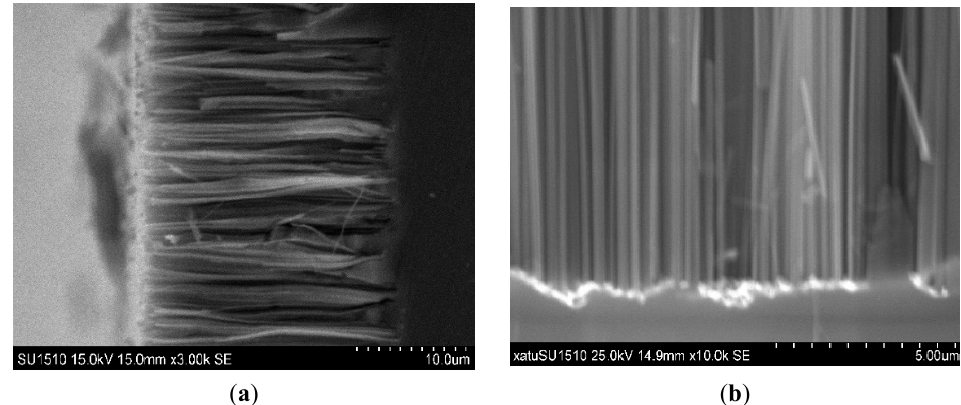
Figure 2. Comparison of cross-sectional views of SiNWs fabricated by two methods: ( a ) SiNWs fabricated with the randomly distributed Ag film; ( b ) SiNWs fabricated with the spatially ordered mesh Au film.